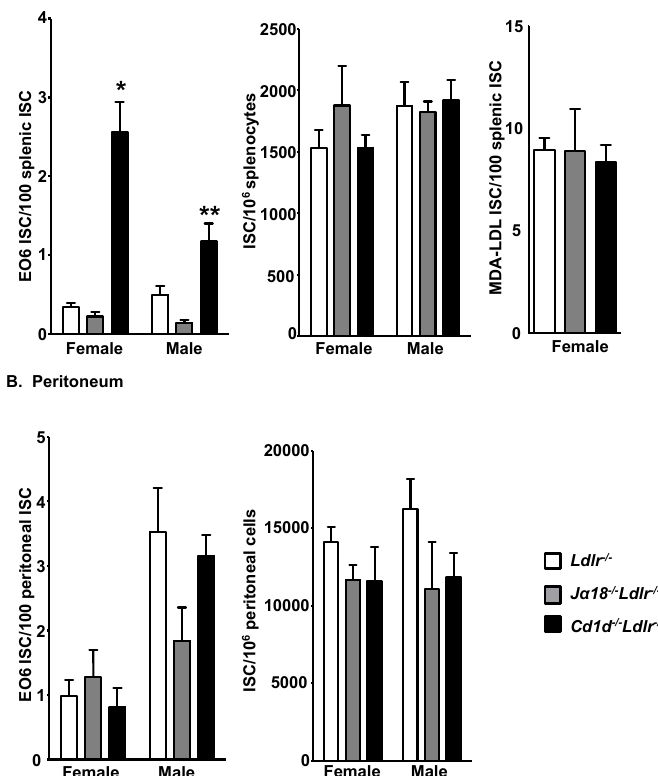
Figure 2. E06 IgM-secreting cells (ISC) are increased in the spleen of Cd1d − / − Ldlr − / − mice. Quantitation of the ELISPOT analysis of cells in the ( A ) spleen and ( B ) peritoneal cavity of chow fed Ldlr − / − , J α 18 − / − Ldlr − / − and Cd1d − / − Ldlr − / − mice producing E06 IgM, total IgM and MDA-LDL IgM. The number of E06 and MDA-LDL IgM-secreting cells are expressed per 100 ISC. The results are the mean ± SEM of n = 11–14 Ldlr − / − and Cd1d − / − Ldlr − / − mice pooled from triplicate independent experiments and n = 3–7 J α 18 − / − Ldlr − / − mice pooled from two independent experiments for splenocytes and n = 5–14 Ldlr − / − and Cd1d − / − Ldlr − / − mice pooled from two independent experiments and n = 3–5 J α 18 − / − Ldlr − / − mice pooled from two independent experiments for peritoneal cells. Significance: * p < 0.0001 and ** p < 0.01 vs. Ldlr − / −